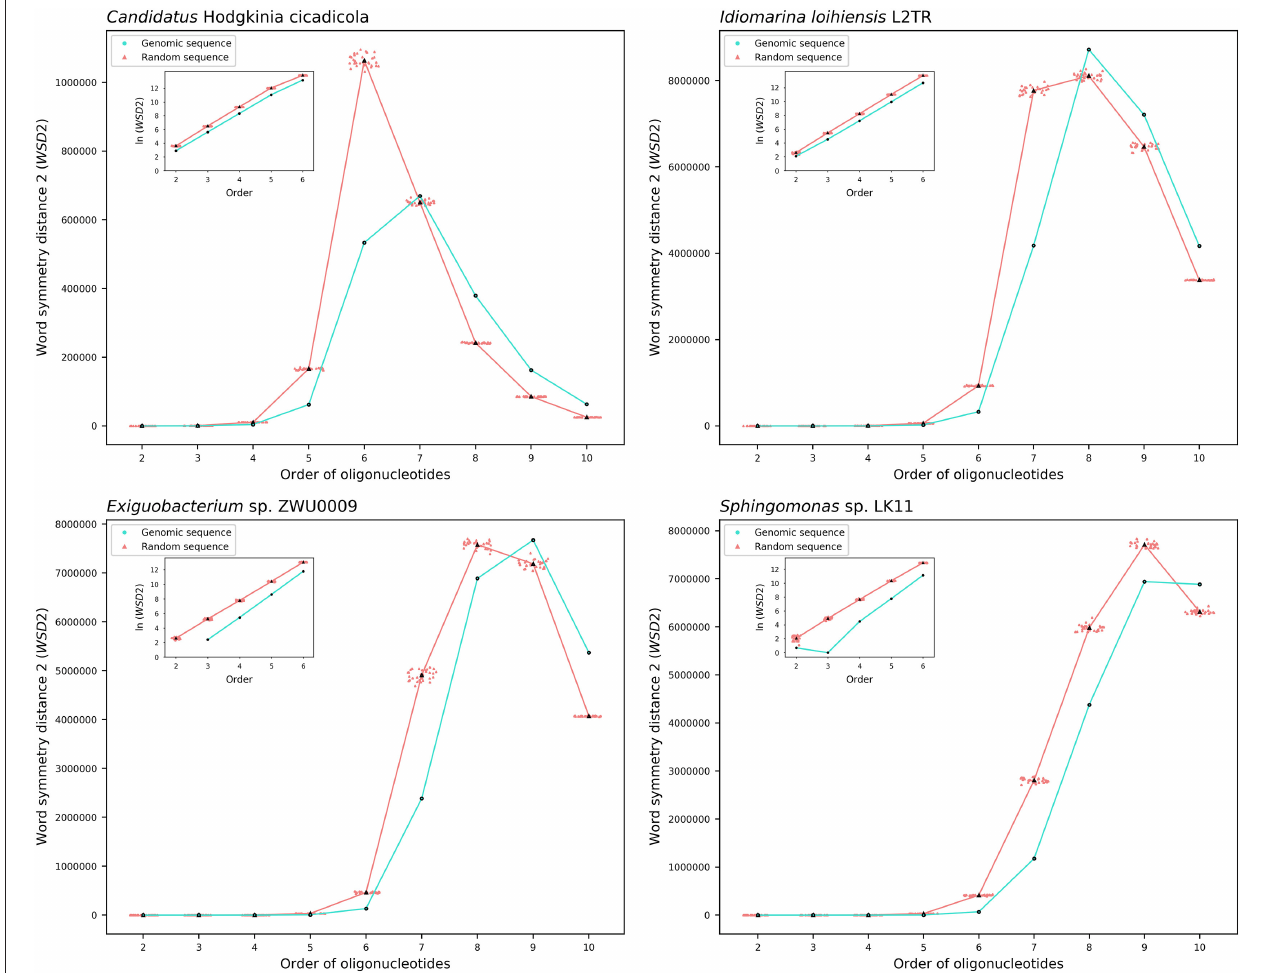
FIGURE 5 | Word symmetry distances ( WSD 2) for four representative bacterial genomes ( Candidatus Hodgkinia cicadicola, Idiomarina loihiensis L2TR, Exiguobacterium sp. ZWU0009, Sphingomonas sp. LK11) and their corresponding random sequences. For other explanations see the legend of Figure 4